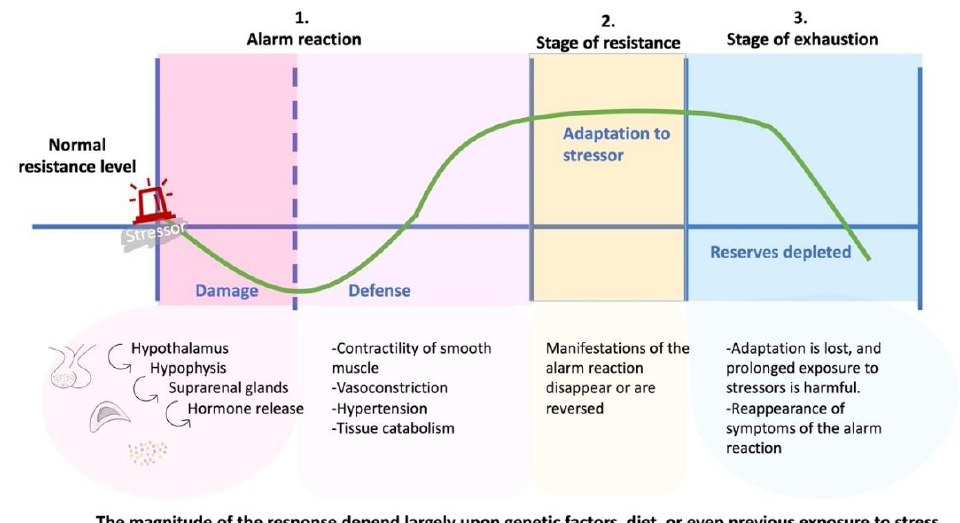
Figure 2. General adaptation syndrome. The general adaptation syndrome is divided into three phases. In the presence of a stressor, phase 1 begins, where the body activates the hypothalamic- pituitary-adrenal axis with the consequent release of hormones to defend itself; in phase 2, symptoms are reduced, and anabolic functions are increased. Phase 3 is exhaustion.